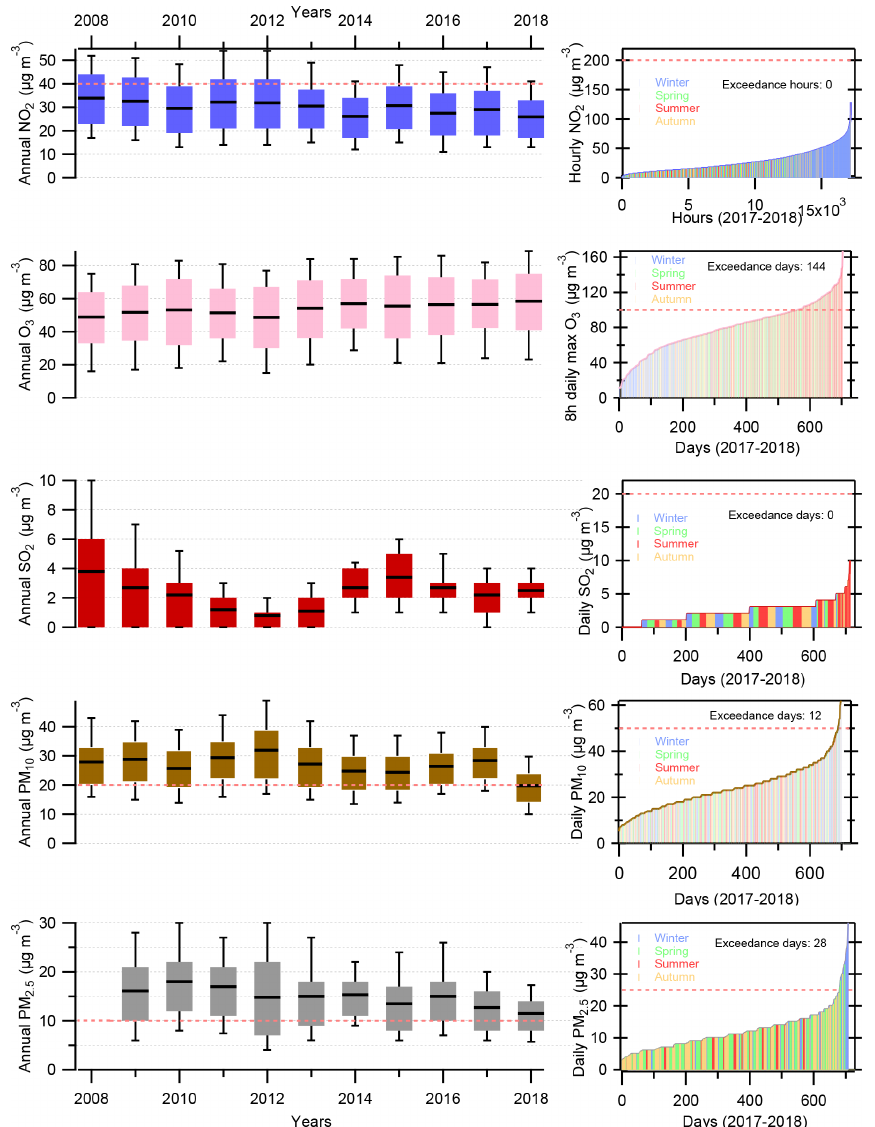
Figure 1. Graphs on the left show annual average concentrations of the following pollutants during the last 11 years in Marseille–Longchamp: nitrogen dioxide (blue), ozone (pink), sulfur dioxide (red), PM 10 (brown) and PM 2 . 5 (grey). The slopes of NO x , O 3 , PM 10 and PM 2 . 5 trends were estimated by the Sen–Theil method, and their significance was evaluated through the non-parametric Mann–Kendall test. The red dotted thresholds correspond to the annual concentrations recommended by the WHO (World Health Organisation) for nitrogen dioxide, PM 10 and PM 2 . 5 . Graphs on the right show data sorted by increasing daily values together with the number of days in excess according to the WHO recommendations (again the red dotted lines) for the years 2017 and 2018. For ozone, it corresponds to the daily maximum 8h average. Sticks for daily values are colour-coded depending on the seasons (winter: blue; spring: green; summer: red; autumn: